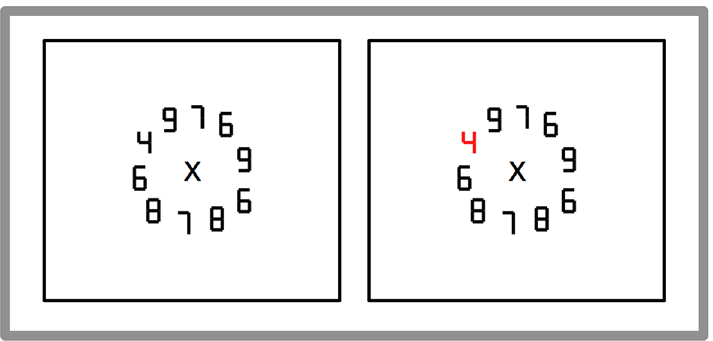
Figure 2. Example digit arrays for serial (left) and parallel search task (right), with the black background and white text color switched for aesthetic